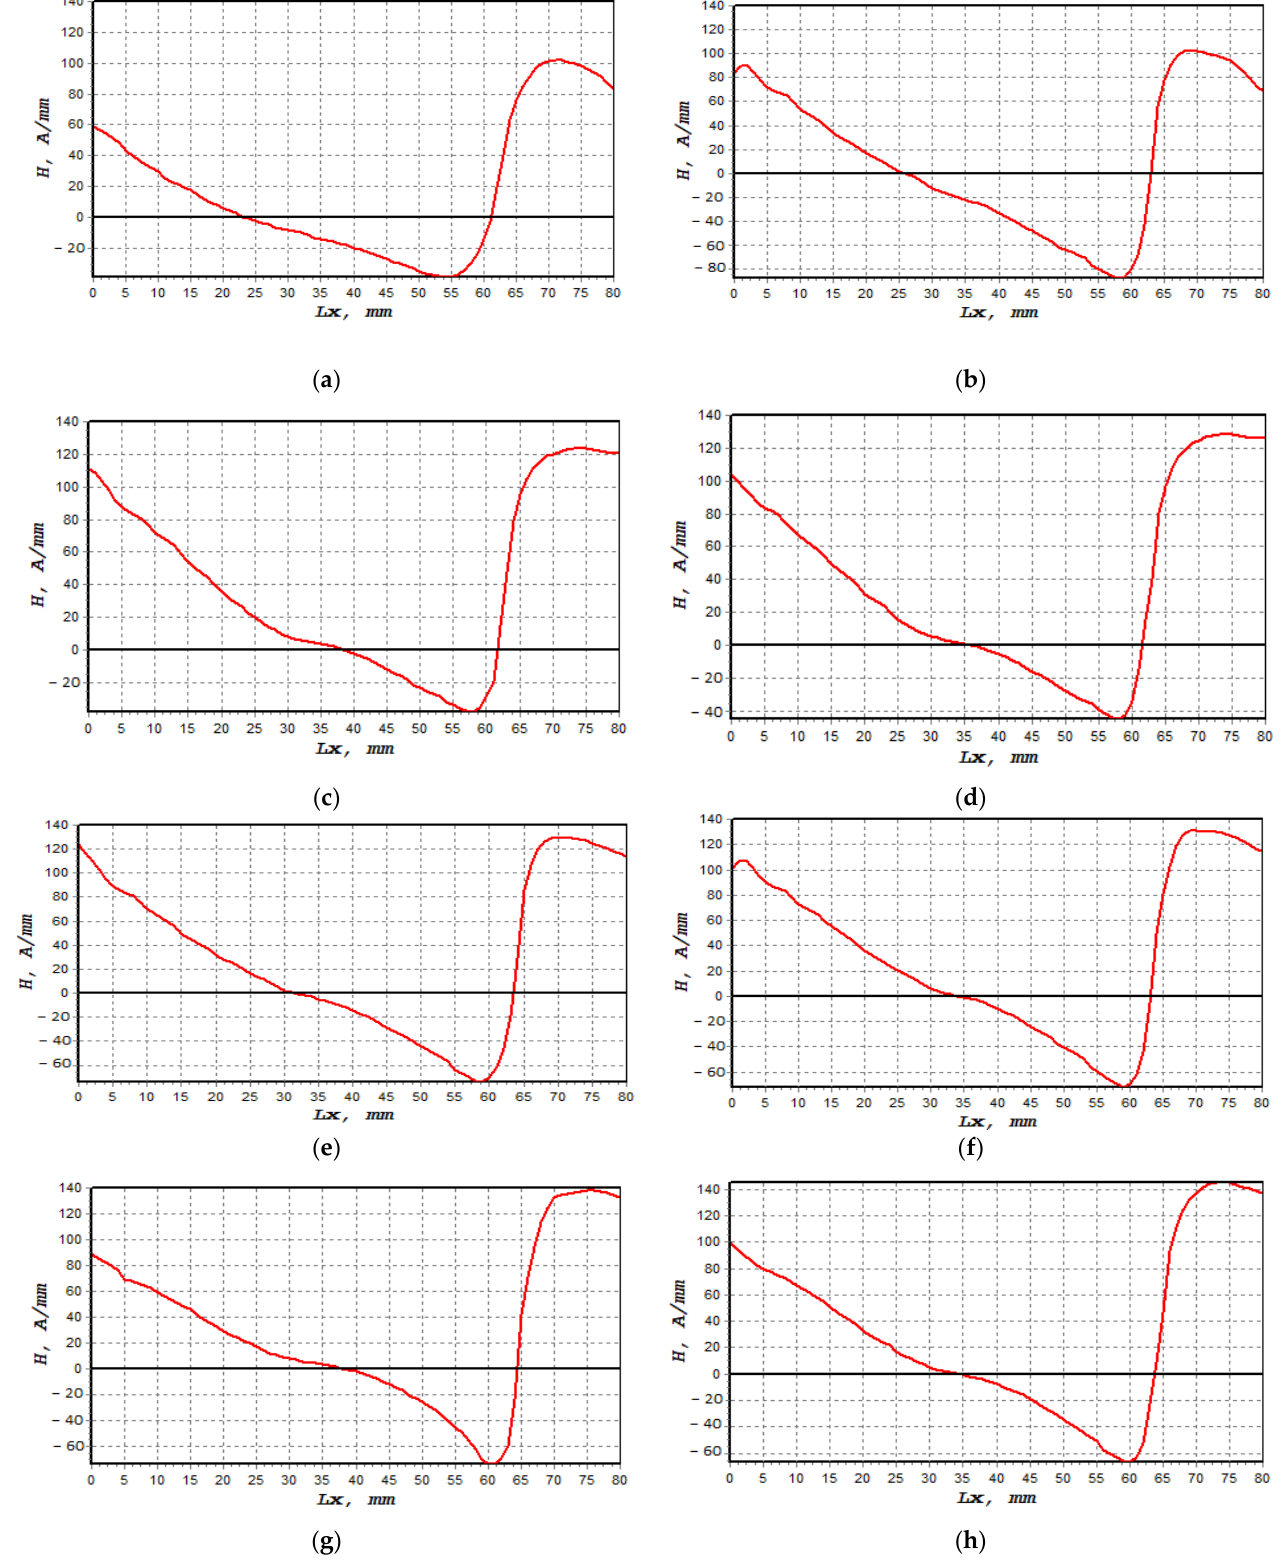
Figure 9. H(y) signal measurements based on UTS cyclic loading percentages: ( a ) 50%, ( b ) 55%, ( c